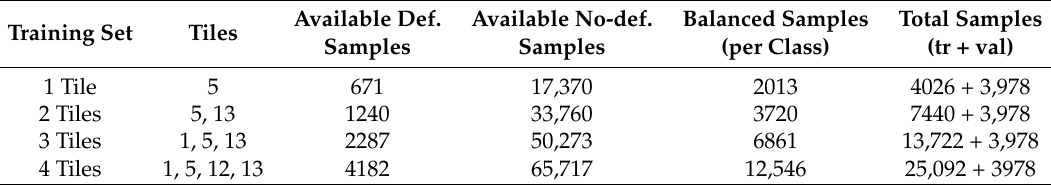
Table 7. Training tiles used for the Cerrado